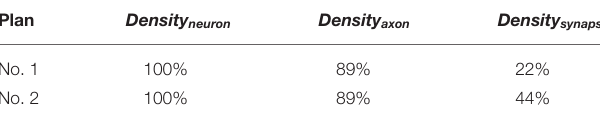
TABLE 3 | Resource efficiency of two plans.